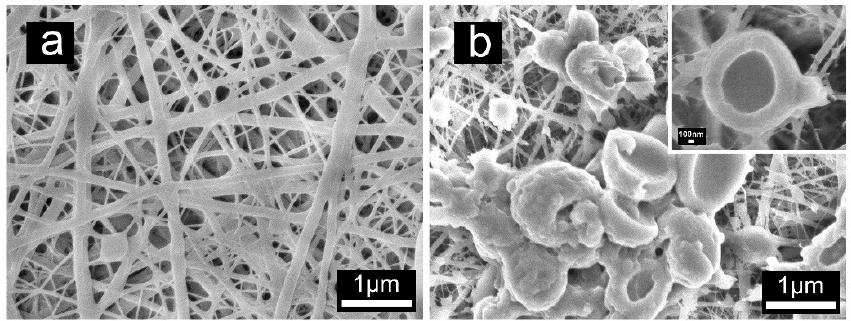
Figure 4. The morphologies of ( a ) CS-L1 and ( b ) CS-L2 membranes after neutralization using 1 M Na 2 CO 3 aqueous solution.